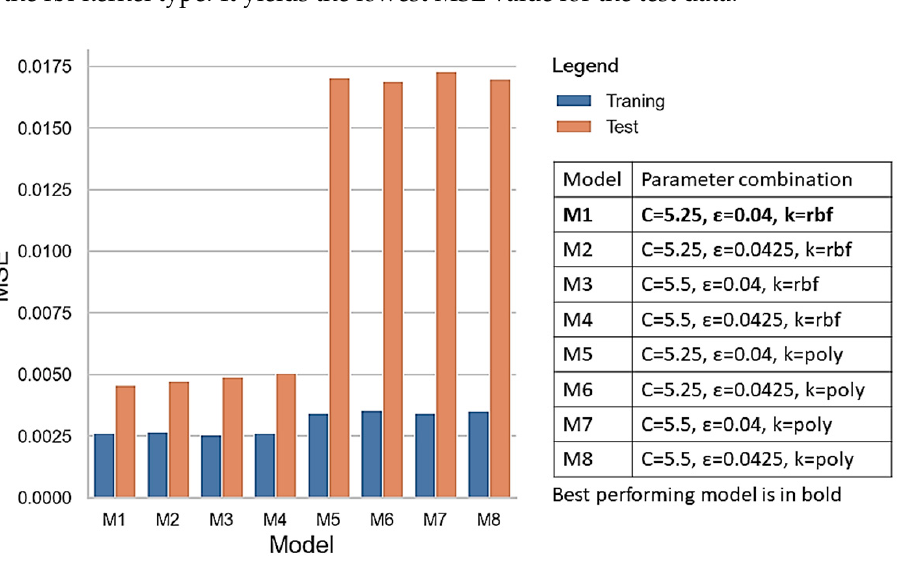
Figure 3. MSE plot for selected SVR hyper-parameter combinations.